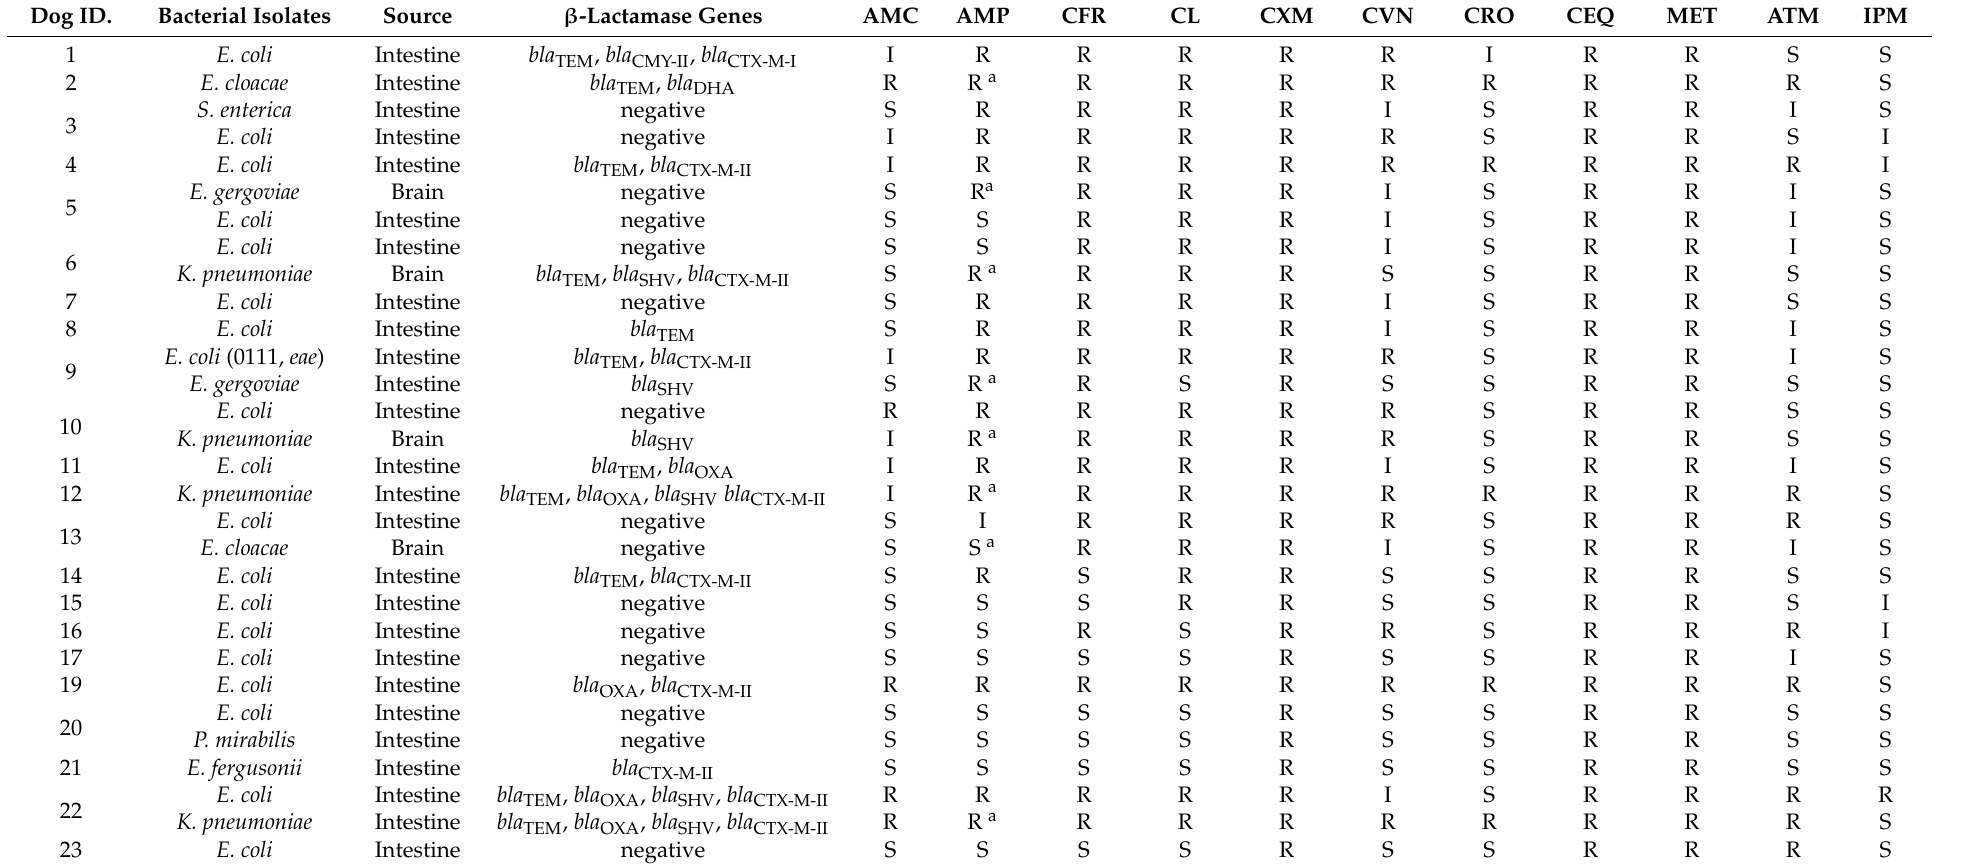
Table 4. β -lactamase genes, and antibiotic sensitivity results derived with the Kirby–Bauer method for the Enterobacteriaceae isolates. Dog